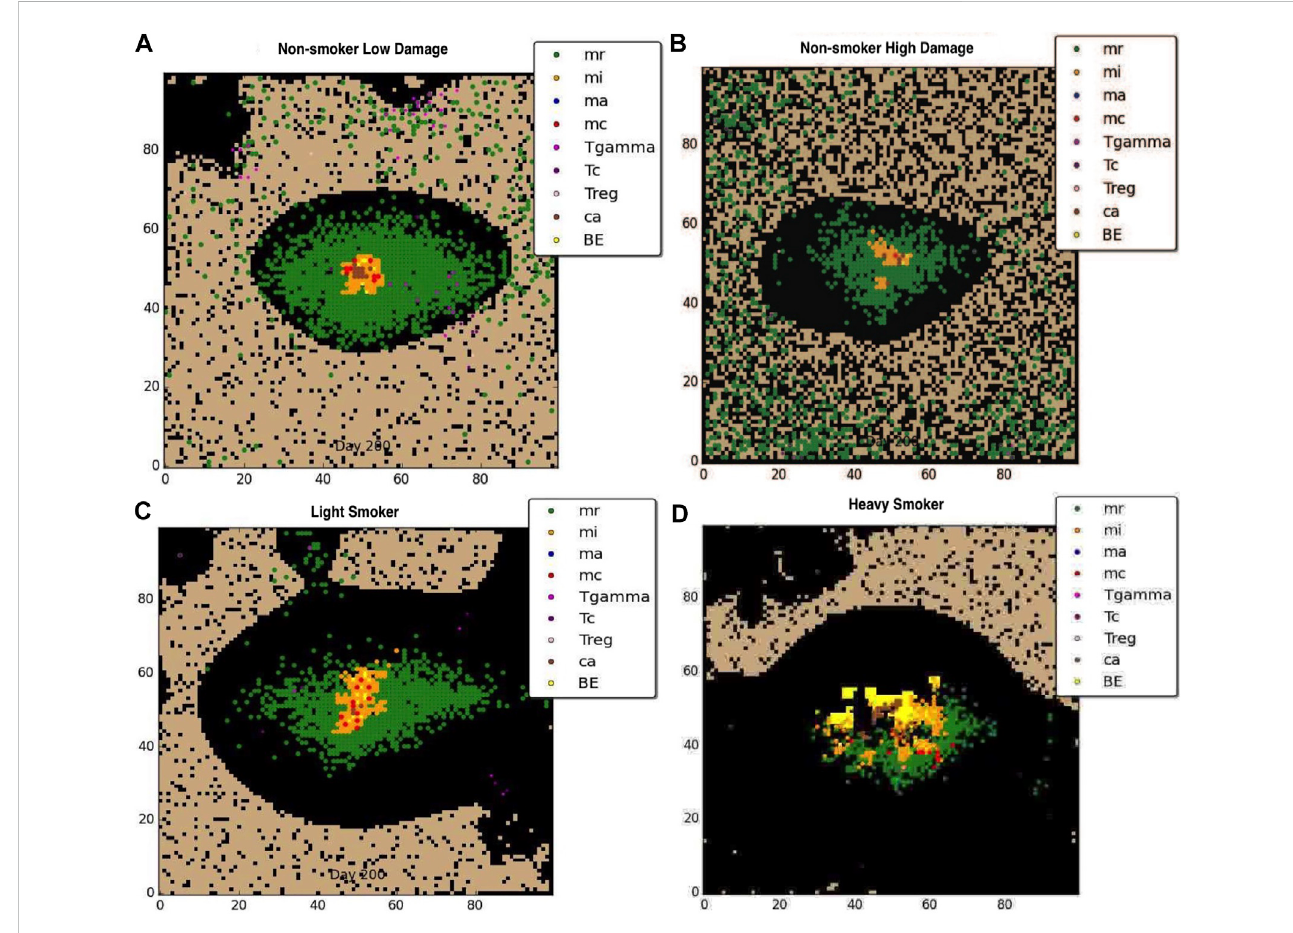
FIGURE 2 Representative granuloma for each of four categories of COPD at 200 days: (A) non-smoker with low damage, (B) non-smoker with high damage, (C) light smoker, (D) heavy smoker. Black represents emphysematous tissue. Note the extensive damage done to the ECM with continued smoking.